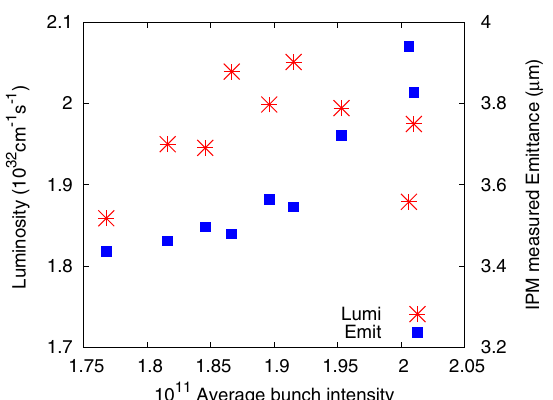
FIG. 22. Luminosities and the luminosity-derived emittances in the 2013 255 GeV proton run when we pushed the proton bunch intensities beyond 2 . 0 × 10 11